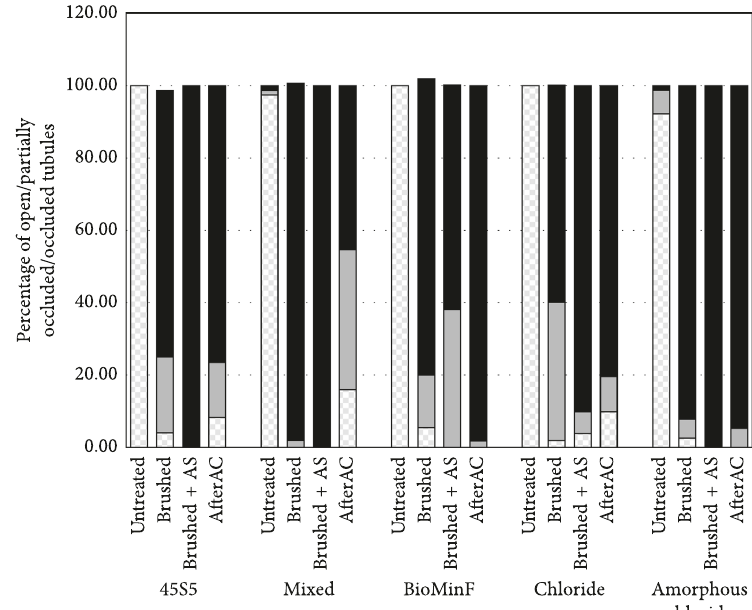
Figure 6: Percentage of open tubules ( ), partially occluded tubules ( ), and occluded tubules ( ) present after different